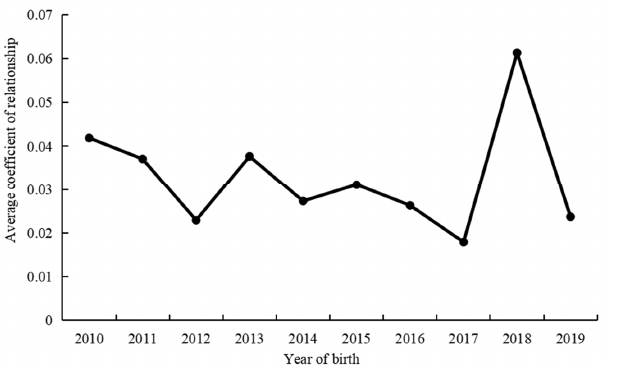
Figure 1. Evolution of average coefficient of relationship between three farms subpopulations according to the year of birth of Simmental cattle.